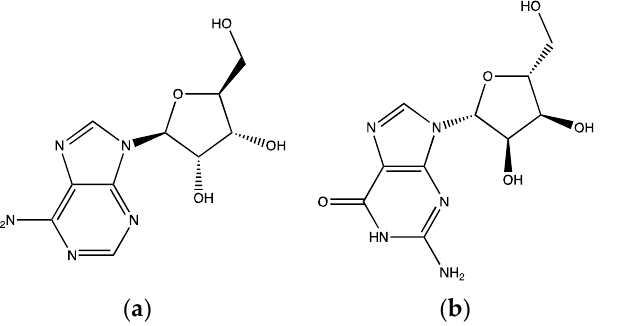
Figure 9. Structure of purine nucleotides isolated from S. lycopersicum; ( a ) adenosine and ( b ) guano- sine.